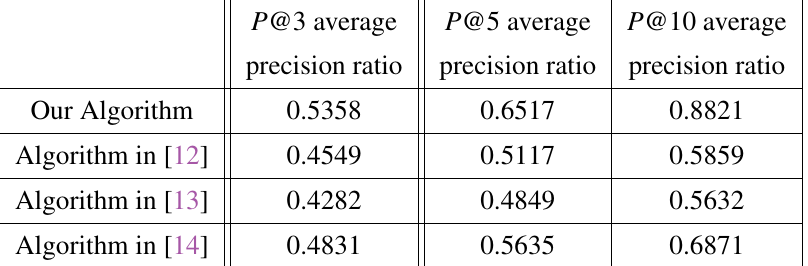
Table 1 Tab. 1.The Experiment Results of Ontology Similarity